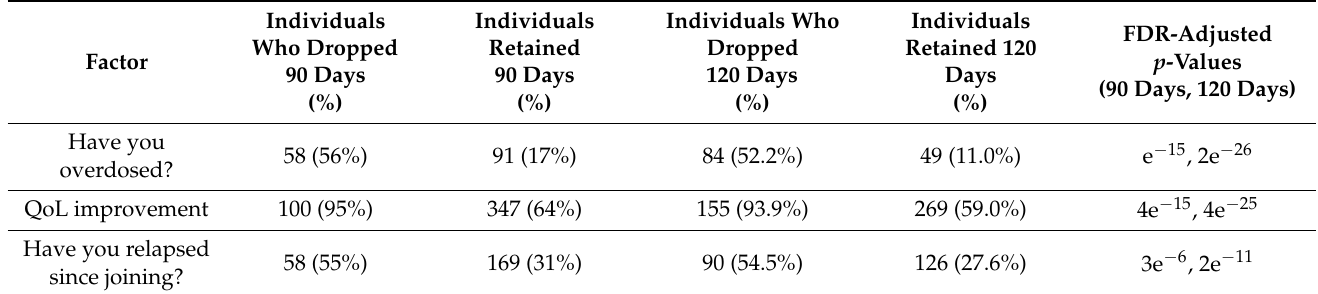
Figure 3. Schematic of the data analysis pipeline. Information on the individuals that are enrolled in the program and longitudinal information is recorded in a REDCap database. A retrospective analysis generated a prediction model based on information collected prior to the index dates at 90 and 120 days. Table 2. Top contributing factors associated with individuals who dropped out at 90 and 120 days. Individuals with missing data are